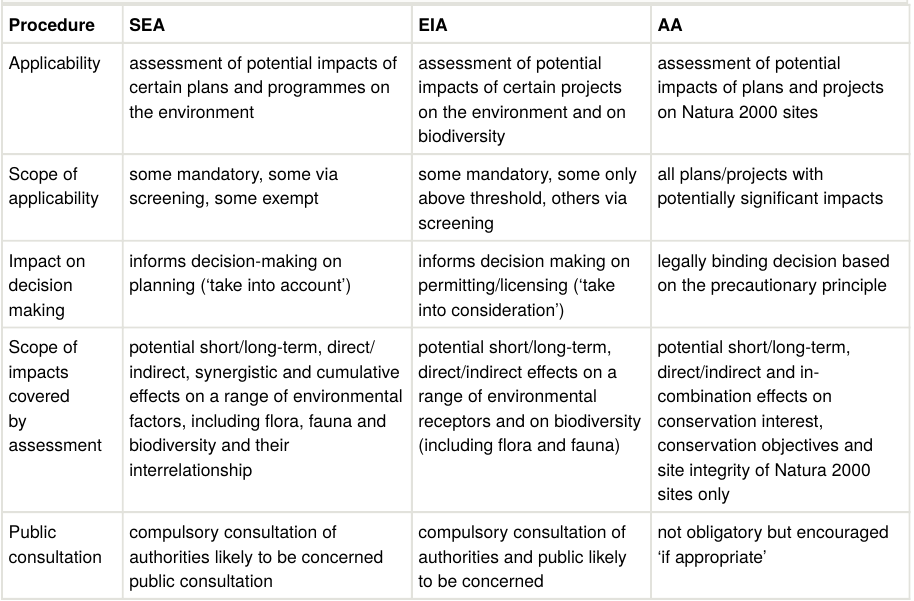
Table 1. Comparison of main legal and procedural di ff erences between Strategic Environmental Assessment, Environmental Impact Assessment and Appropriate Assessment (compilation based on Gonzalez et al. 2012McCracken 2010Royal HaskoningDHV